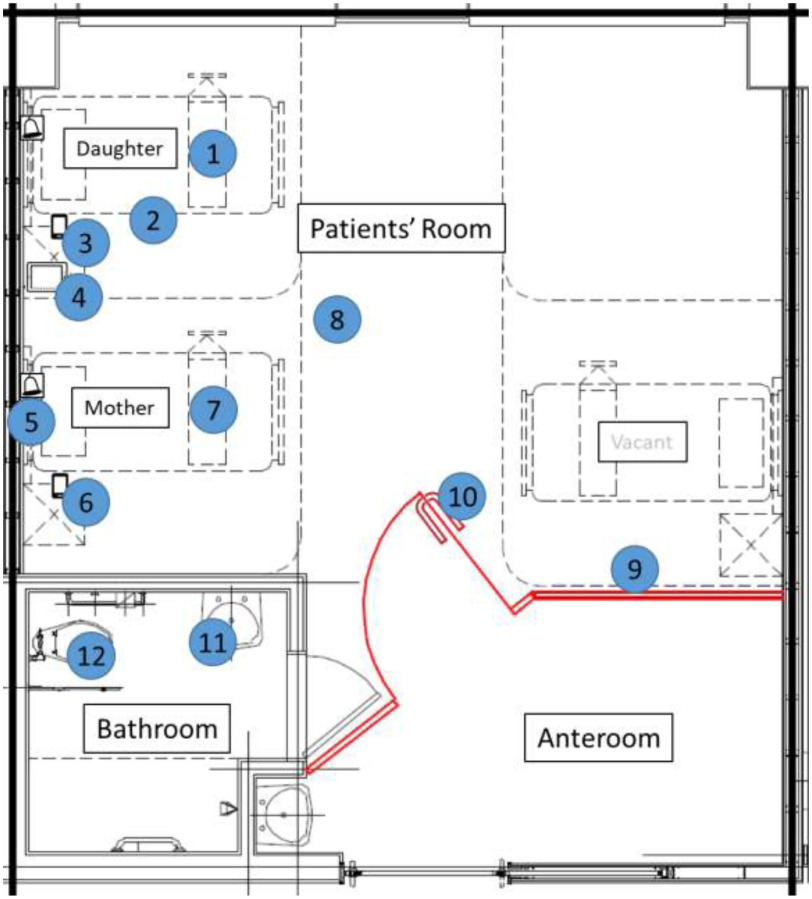
Room layout showing environmental sampling sites. Numbers are labeled corresponding to environmental sampling sites: 1, bedside table (daughter); 2, entire length of bed rail (daughter); 3, mobile phone (daughter); 4, tablet (daughter); 5, call bell attached to bed (mother); 6, mobile phone (mother); 7, bedside table (mother); 8, floor; 9, in room wall panel; 10, door handle; 11, sink (bathroom); 12, toilet bowel.